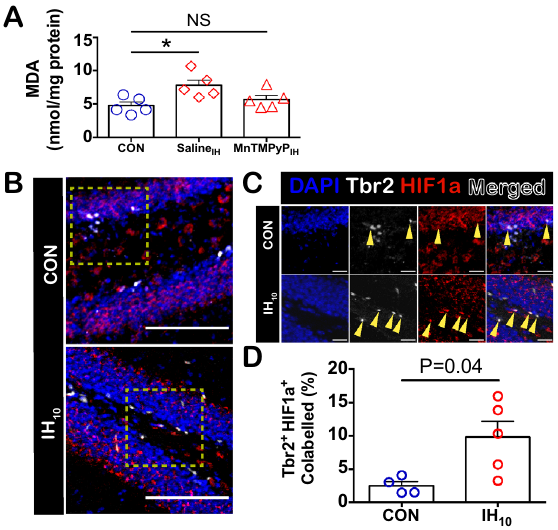
Figure 5. IH 10 increases hippocampal oxidative stress and HIF1a expression in Tbr2 + cells. ( A ) Following exposure to IH, oxidative stress as quantified by MDA content was increased in IH 10 animals (Saline IH , red diamonds). In contrast, MDA content in IH 10 animals that received concurrent MnTMPyP treatment (MnTMPyP IH , red triangles) was not significantly different when compared to control animals (CON: n = 5, Saline IH : n = 5, MnTMPyP IH : n = 5). One-way ANOVA with Dunnett’s multiple comparisons: P = 0.0232, F = 5.234. CON vs Saline IH : P < 0.05, Cl of diff = − 5.455 to − 0.6288. CON vs MnTMPyP IH : P > 0.05, Cl of diff = − 3.334 to 1.493 ( B ). Representative images for CON and IH 10 are shown. Scale bars are 100 μm. Yellow boxes highlight the inset images. ( C ) Inset images are shown. Yellow triangles indicate examples of co-labeled cells for CON and IH 10 . Scale bars for inset images are 20 μm. ( D ) An increased proportion of HIF1a + Tbr2 + INPs was observed following IH 10 (CON: n = 4, IH 10 : n = 5).